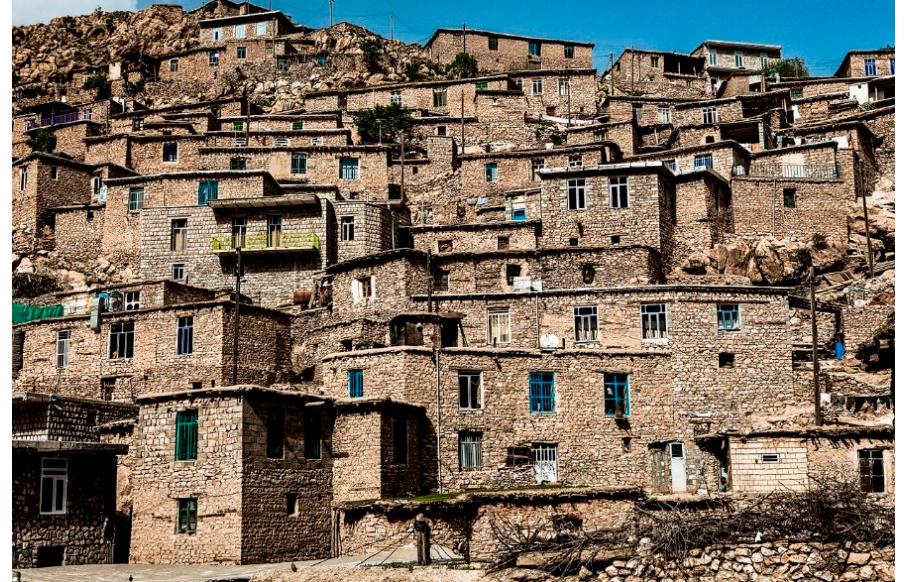
Figure 1. Palangan village, Iran.